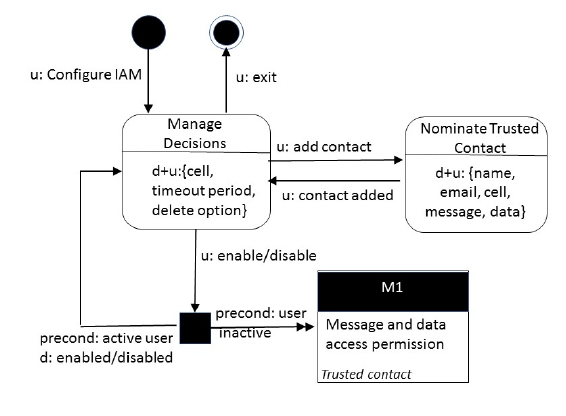
Fig. 6. - MoLICC diagram for account owner